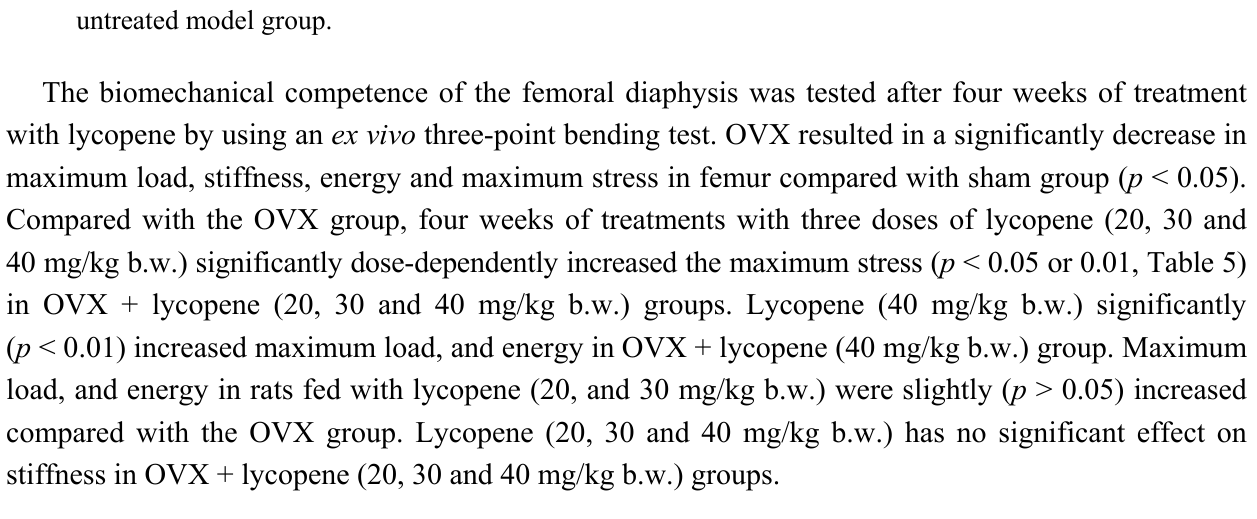
Table 5. Effect of lycopene on maximum load, stiffness, energy and maximum stress in experimental rats. Group (N) Sham Untreated model (OVX) 143.85 ± 11.26 ** OVX + lycopene (20 mg/kg b.w.) OVX + lycopene (30 mg/kg b.w.) OVX + lycopene (40 mg/kg